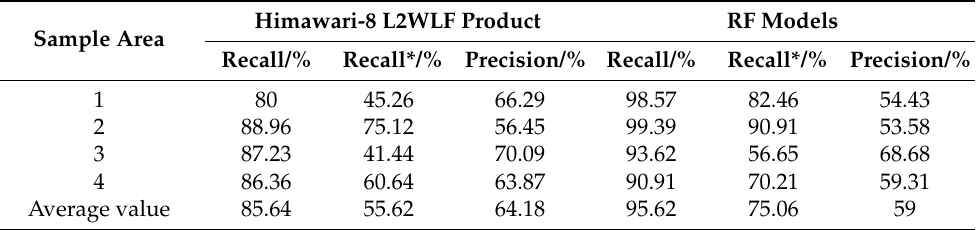
Table 4. RF models and Himawari-8 L2WLF product accuracy evaluation on the test sample